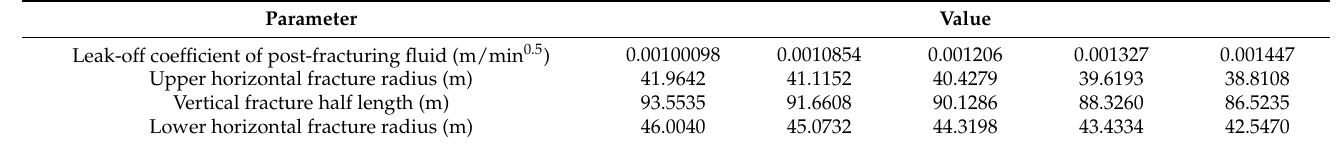
Table 6. Fracture geometry changes with leak-off coefficient of post-fracturing fluid.